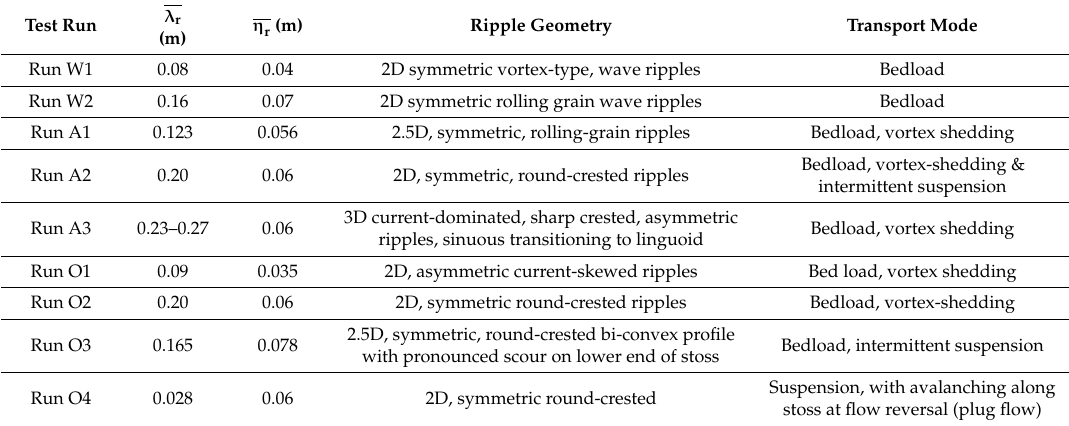
Table 2. Observed bed morphology and mode of sediment transport in each test run: λ r : mean ripple wavelength; η r : mean ripple